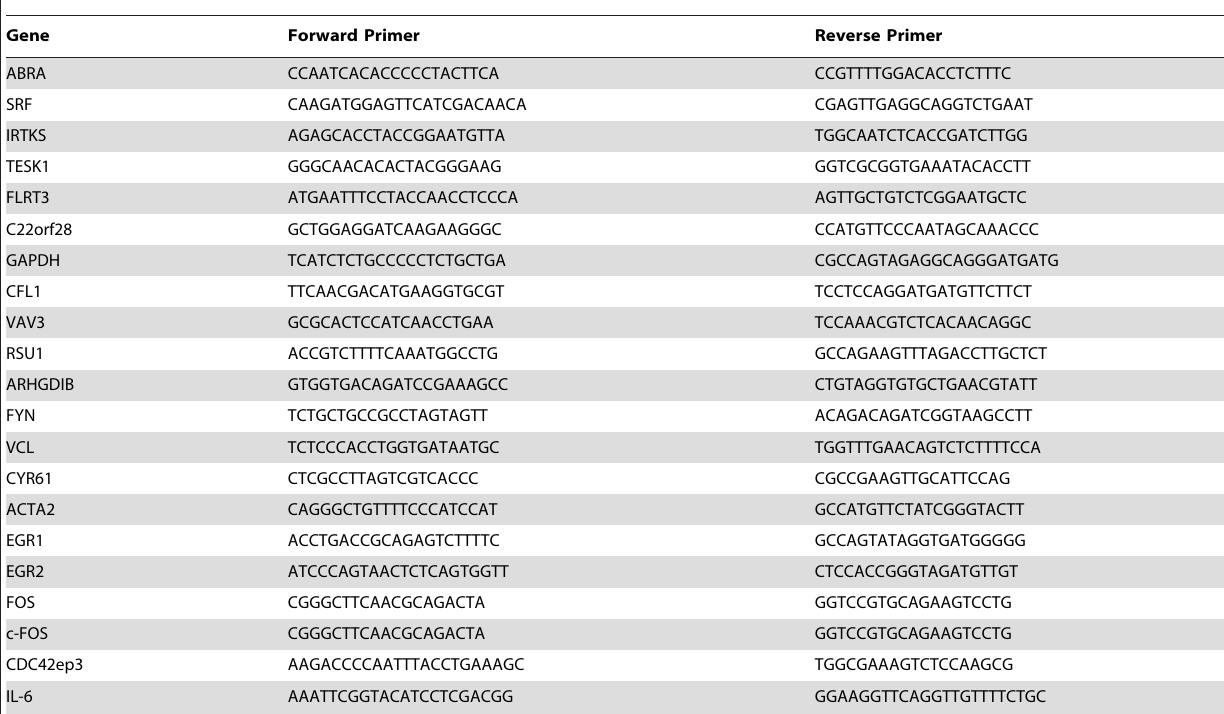
Table 3. RT-PCR primer